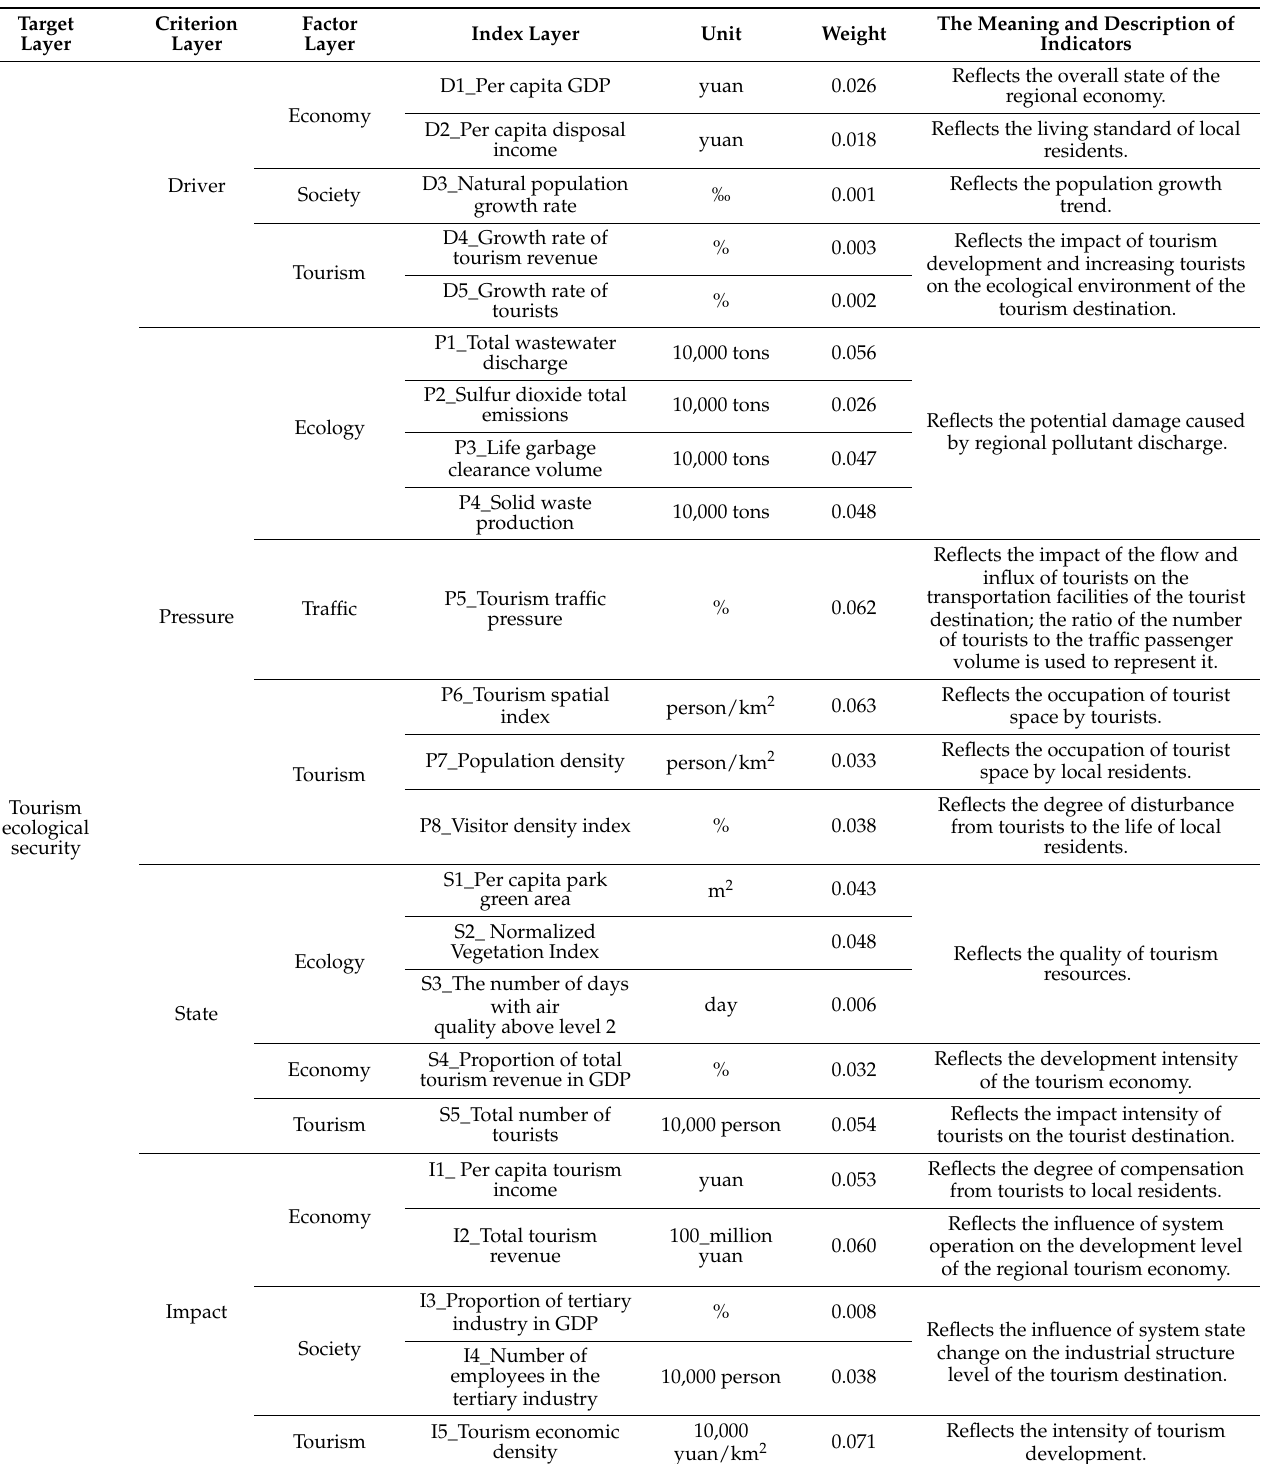
Table 1. Comprehensive evaluation index system of tourism eco-security in the Yellow River